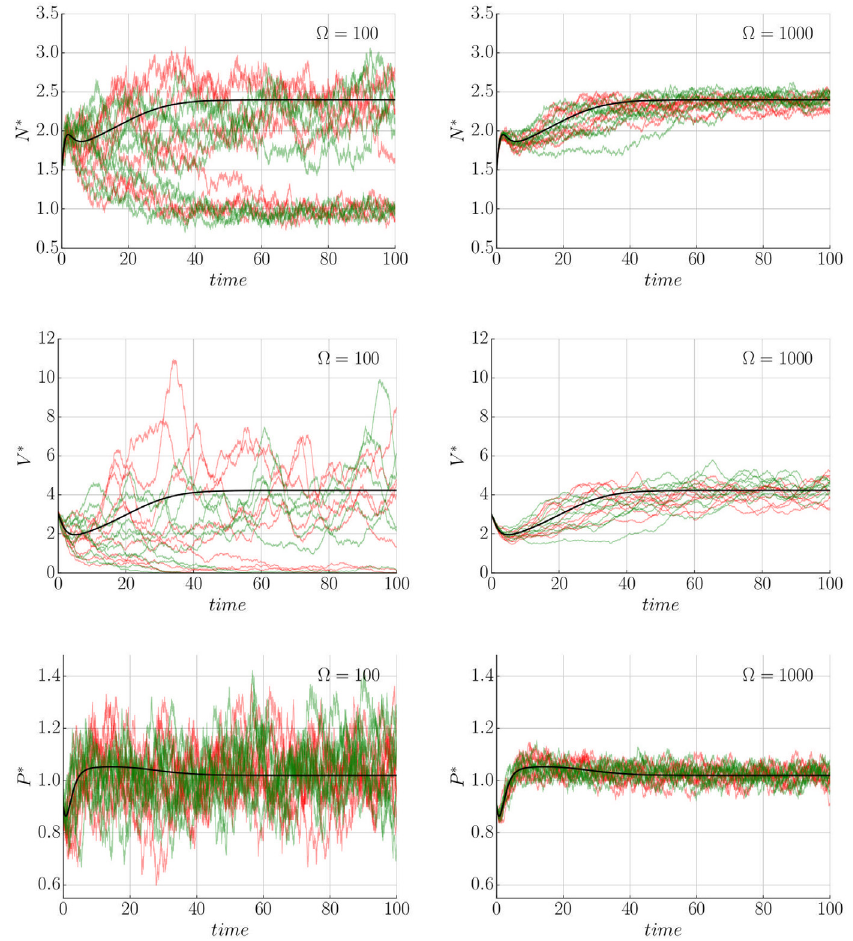
Fig 4. Fluctuations change the macroscopic evolution of the tumour. Deterministic solution (black) compared with 10 different realizations of Gillespie (red) and Langevin (green) for two different values of Ω = 100,1000. Time courses show variability around the macroscopic description and even jumps to different tumour states. Initial condition (1.5, 0.9, 3.0) and parameters are α = 1.0, δ N = 1.1, δ P = 0.34, K = 1.0, b 1 = 2.3, a c a m b n = 2, n n n n c 1 = 1.5, 2 = 0.4, 2 = 1.0, 3 = 1.0, 3 = 1.02, 3 = 1.0, 1 = 1, 2 = 2 and 3 = 4 = 2 (see